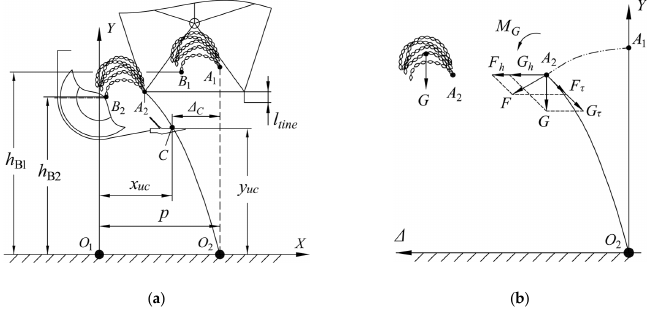
Figure 2. Rice plant ( a ) deformation and ( b ) force analysis before cut by the upper cutterbar. x uc , y uc are the horizontal and vertical coordinates of the upper cutterbar blade midpoint in mm, respectively; F is the reel acting force exerted on stalk, and F h , F τ are its component forces on horizontal and tangential direction, N; G is the gravity of the panicle, and G h , G τ are its component forces on horizontal and tangential direction, N; M G is the additional torque when the G is moved to point A 2 , N·mm; h B 1 and h B 2 are the heights of the panicle lowest point before and after deformation, mm; Δ C is the plant deflection at the height of the upper cutterbar, mm; p is the distance between crop and auger center, mm; l tine is the length of the reel tine, mm . To calculate the deformation of the whole rice crop, the assumptions that the plant is bent elastically by the reel and the panicle is moved translationally were made. To facilitate the calculation, another coordinate system Δ O 2 Y describing the rice crop deformation was established. The force analysis of the rice crop bent to O 2 A 2 is illustrated in Figure 2b. The forces acting on the crop include the force F exerted by the reel and the weight of the panicle G , which are acted on point A 2 and the center of the panicle, respectively. The weight G can be moved to point A 2 with an additional torque ( M G ). Furthermore, F and G can be decomposed into horizontal forces F h , G h and tangential forces F τ , G τ . The tangential forces give the elongation on the surface of the stalk at point A 2 , but the effect on the bending is considered to be very slight [11]. Thus, the tangential forces are neglected in the deformation calculation. The torque M G can be transformed to a horizontal force F M acting at point A 2 . Therefore, the resultant force at point A 2 can be presented as follow: (cid:1832) (cid:3045)(cid:3032) = (cid:1832) (cid:3035) (cid:3397) (cid:1833) (cid:3035) (cid:3397) (cid:1832) (cid:3014) (1) The curve of the stalk O 2 A 2 as shown in Figure 3 can be fitted by substituting F re into Equation (2), the large deflection formula [14], which can be solved by the fourth-order Runge– Kutta method [14,17].